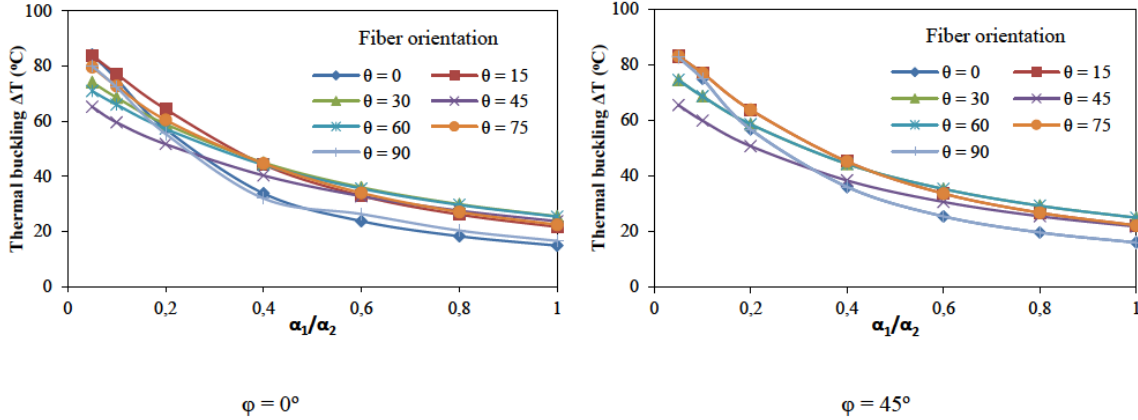
Figure 4: Effect of thermal expansion coeflcient on the thermal buckling load.